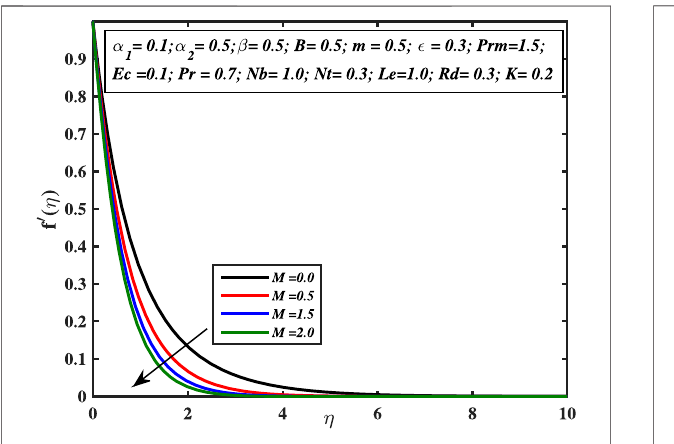
FIGURE 5 | Effect of M on the velocity curve.